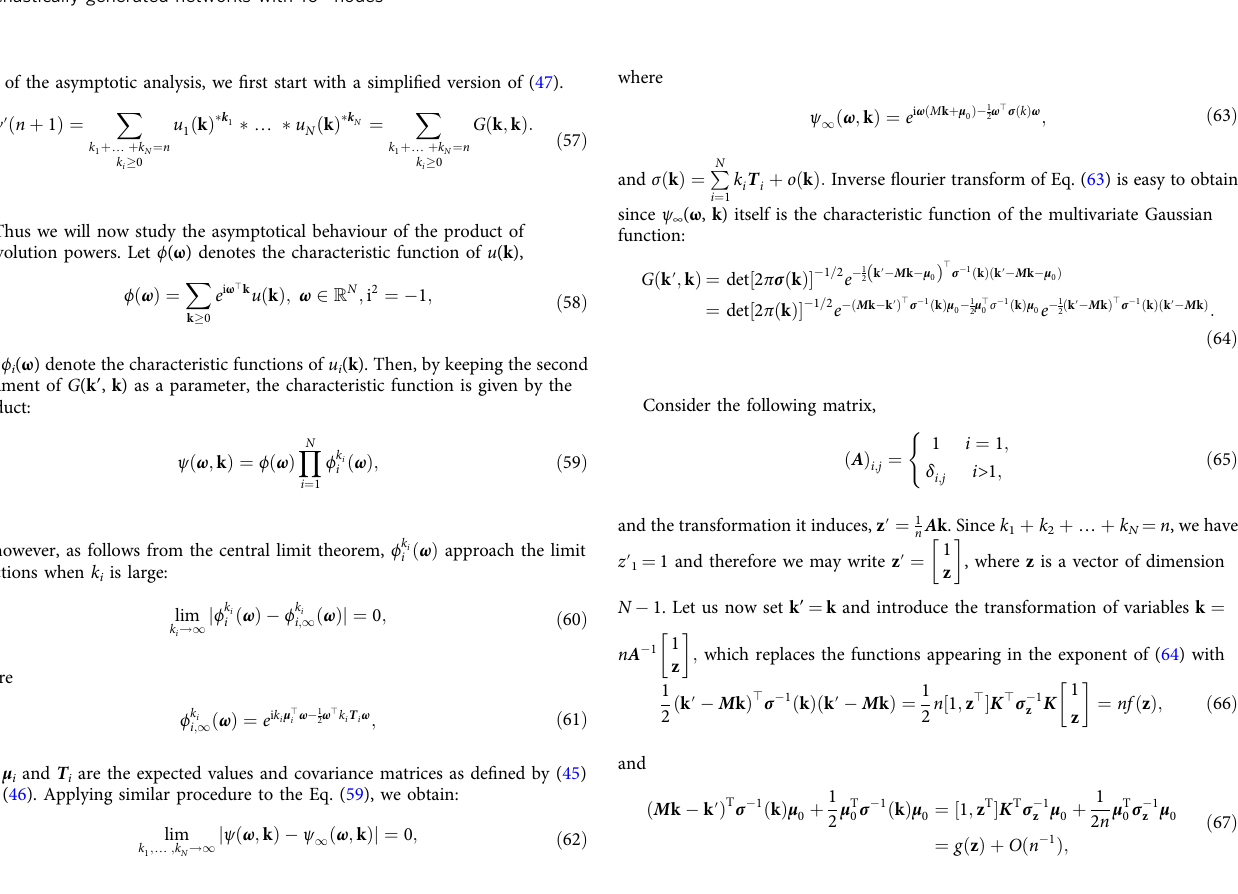
Fig. 7 Colour-dependent percolation that features wide critical regimes. Networks corresponding to the degree distribution de fi ned by Eq. (36) with: a – c α = 0 and d – f α = 0.1. a , d Optimal percolation paths p ( t ) together with the reference isosurfaces ( C optimal paths. c , f Comparisons of the theoretical weighted-average component size pro fi les against the corresponding pro fi les extracted from stochastically generated networks with 10 5